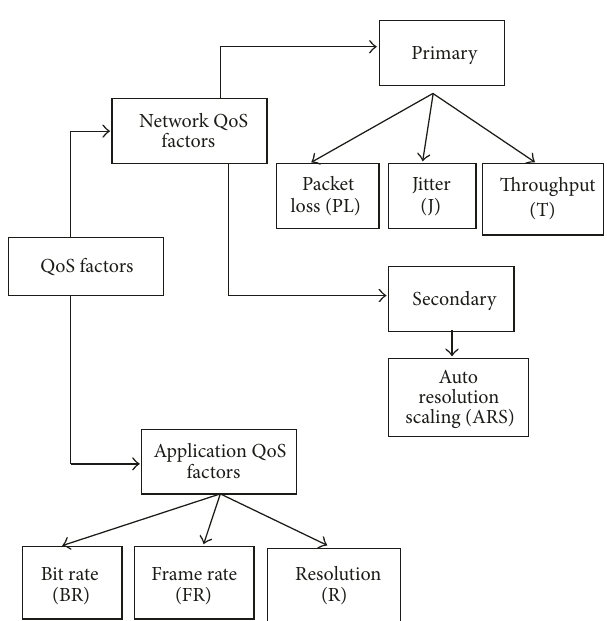
Figure 1: Classification of QoS